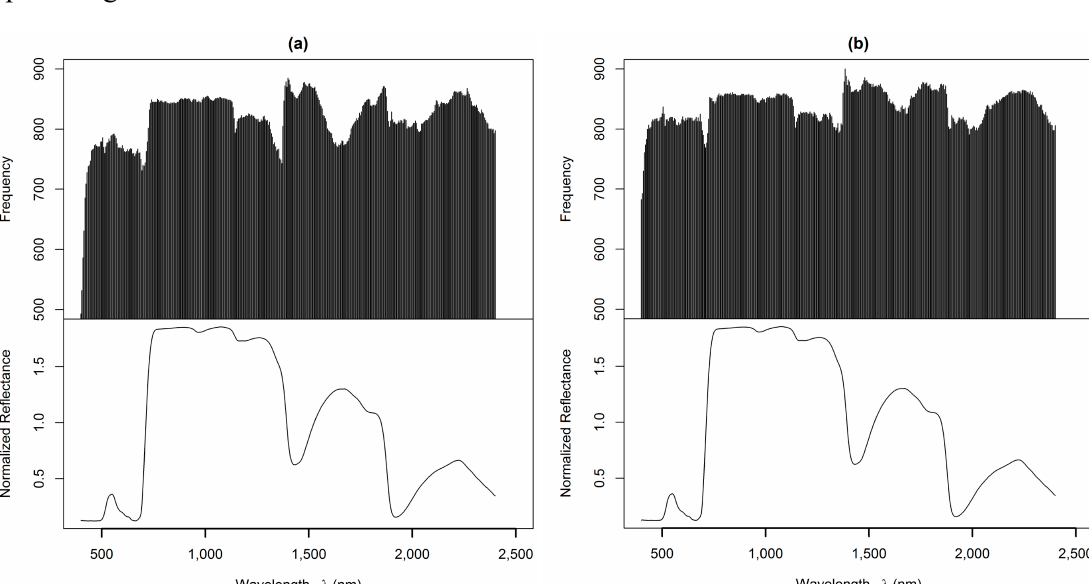
Figure 4. ( a ) Frequency distribution of ANOVA of all 401 5-nm wavebands from 400 to 2,400 nm (top), for every paired species across the 46 species. Bars represent the number paired species for which the spectral variable difference is significant at the 0.01 probability level. ( b ) (Top) Frequency plot of statistically significant differences using the Mann–Whitney U -test of all 401 5-nm wavebands from 400 to 2,400 nm, for every paired species across the 46 species. Bars represent the frequency of paired species for which a spectral variable difference is significant at the 9.7 × 10 − 6 significance level. For both (a) and (b) (bottom), the mean reflectance curve of TELA ( Terminalia latifolia ) to indicate typical vegetation reflectance